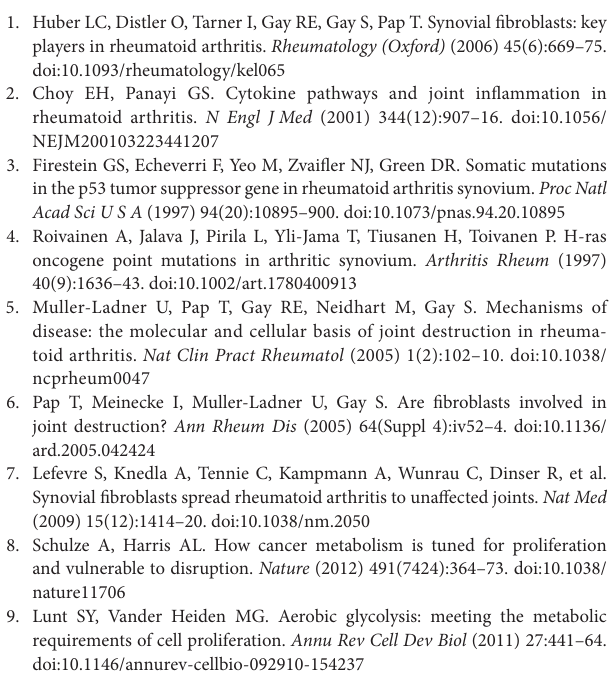
FigUre s3 | Effect of dexamethasone (DXM) or methotrexate (MTX) on AMP-activated protein kinase activity. Rheumatoid arthritis fibroblast-like synoviocytes (FLSs) were treated with 1 µg/ml DXM or 10 µg/ml MTX for 24 h. Representative images of immune blots are shown (left panel), and data from densitometric quantification (right panel) are expressed as the mean ± SD of three independent experiments. ** P < 0.01 vs. Ctrl. FigUre s4 | AMP-activated protein kinase (AMPK) β mRNA expression in synovial tissues. Representative expression of AMPK β 1 (PRKAB1) and AMPK β 2 (PRKAB2) from healthy control ( n = 6) and patients with osteoarthritis ( n = 6) and rheumatoid arthritis ( n = 6). FigUre s5 | Increased expression of hypoxia-inducible factor (HIF)-1 α in fibroblast-like synoviocyte (FLS) from rheumatoid arthritis (RA) patients. (a) Expression of the HIF1A gene in FLSs. Gene expression was analyzed by quantitative real-time PCR. The data are presented as the mean ± SD from healthy control (HC) ( n = 5) and patients with osteoarthritis (OA) ( n = 6) and RA ( n = 9). (B) Protein expression of HIF-1 α in FLSs. HIF-1 α expression was detected by Western blot analysis. Representative images of immune blot (left panel) and densitometric quantification (mean ± SD, right panel) from HC ( n = 5) and patients with OA (n = 6) and RA (n = 9). *P < 0.05, **P < 0.01 vs. HC or